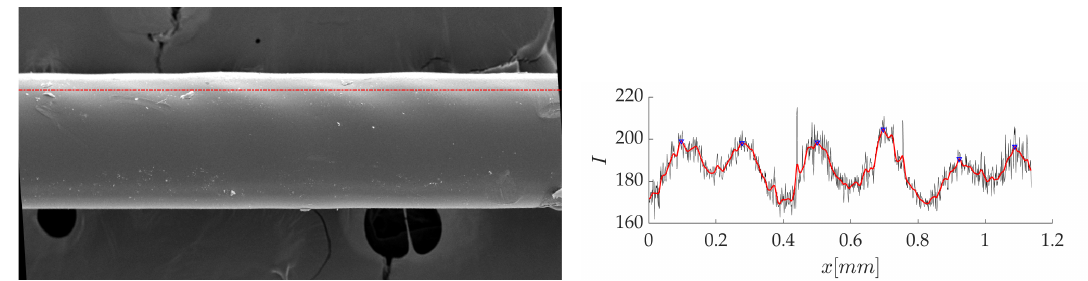
Figure 22. Longitudinal analysis of the solidified strand.